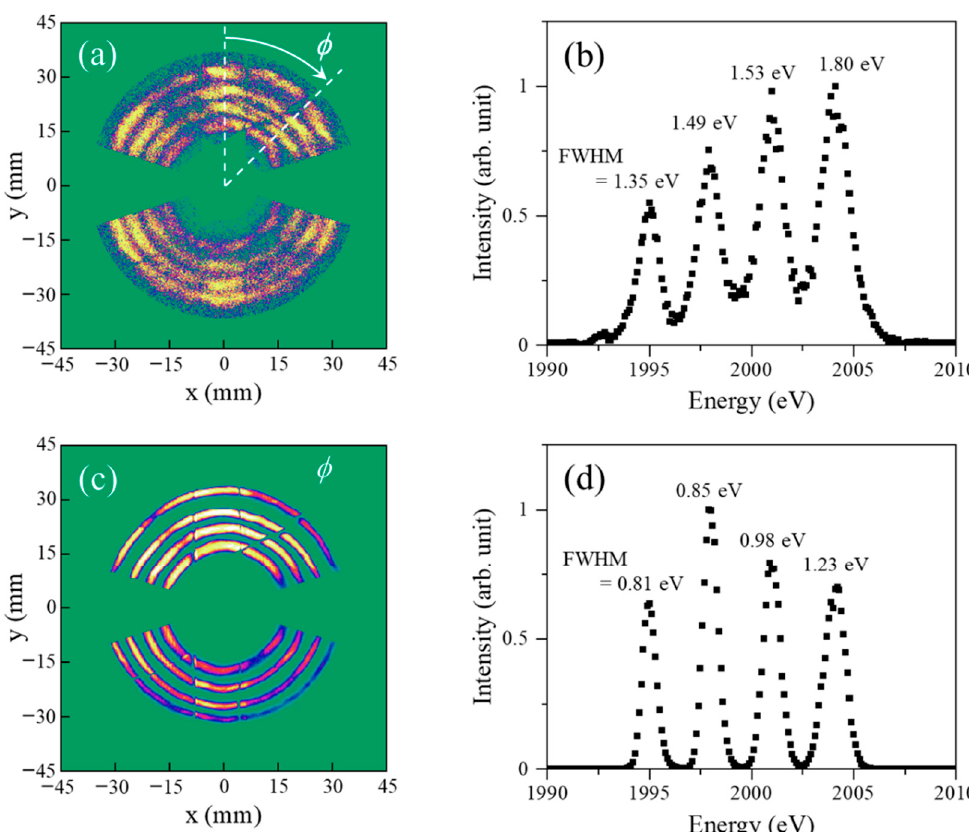
Figure 5. ( a ) Two-dimensional image of electrons backscattered quasi-elastically from Xe, measured with the TR-AMS apparatus. ( b ) One-dimensional energy spectrum generated by integration of the two-dimensional data over the azimuthal angle φ . ( c , d ) are those measured with the traditional AMS apparatus [12]. See text for details.